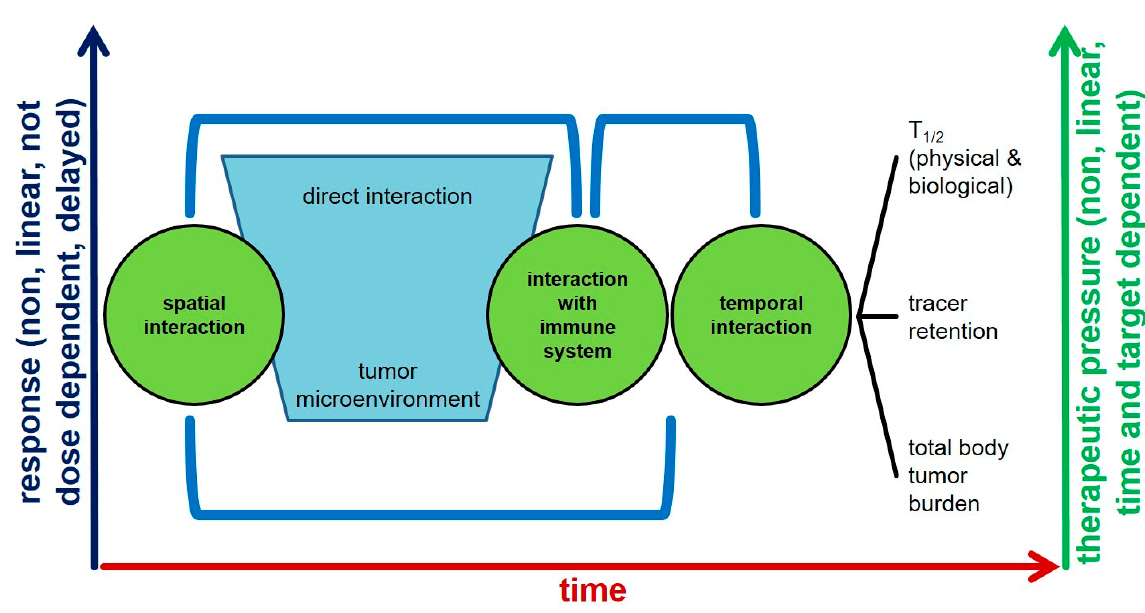
Figure 4. Radioligand therapy interaction with a cancer patient’s (closed) system. There are three ways in which a radioligand interacts with a tumor: (a) spatial interaction may be direct binding of the radioligand to the specific target on tumor or through interaction with tumor microenvironment e.g., vessels; (b) radioligand leads to modulation of tumor microenvironment to immune system and thus contributes to the efficacy of the treatment; and (c) temporal interaction due to differential physical and biological half-life, different rates of internationalization of the receptor–radioligand complex and also through the influence of amount of tumor burden in a patient as it directly influences the pharmacokinetics of the drug.